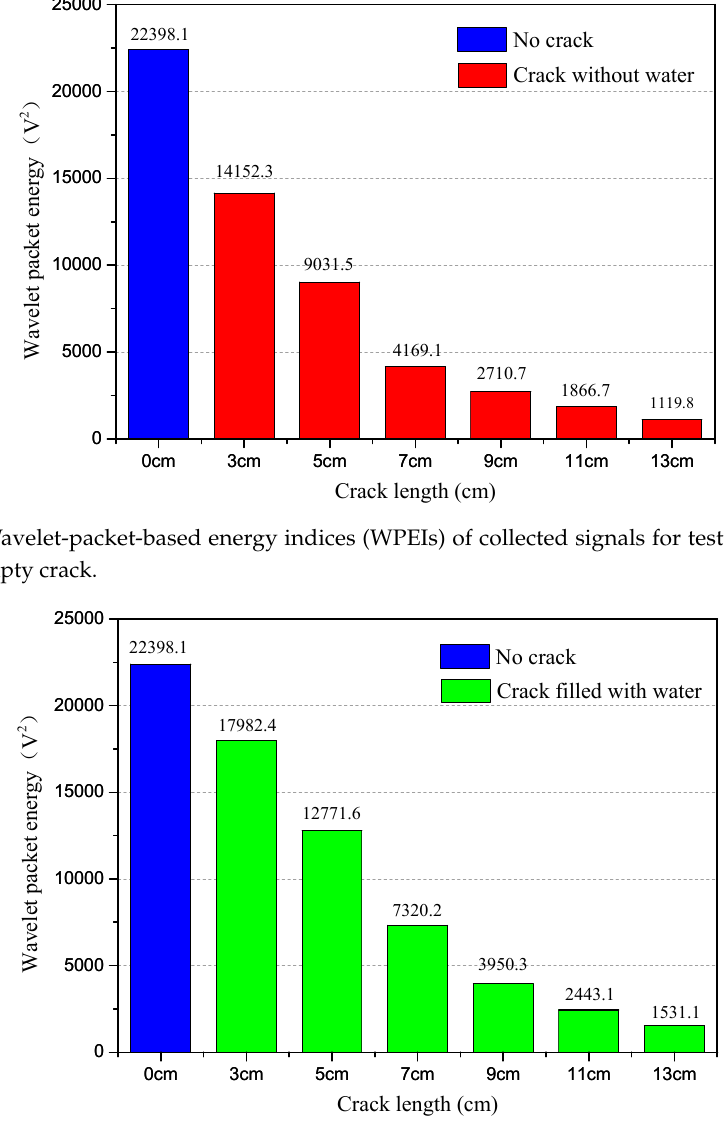
Figure 14. WPEIs of collected signals for test cases with no crack and water-filled crack.